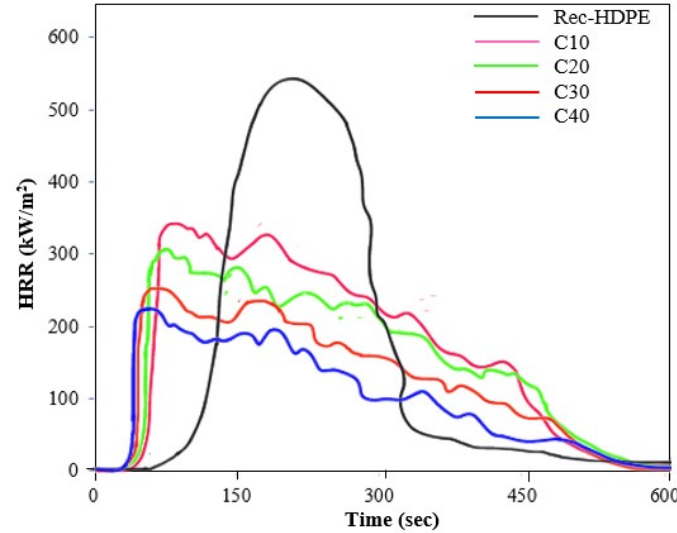
Figure 6. Heat release rate of the recycled HDPE and composites.